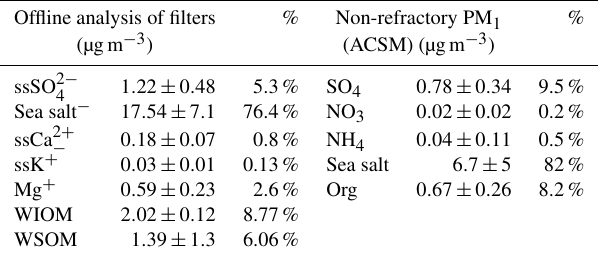
Table 1. Concentrations of different chemical species in PM 1 pri- mary seawater aerosols measured using offline analysis of filters and online measurements from the ACSM. The cited uncertainty represents 1 σ